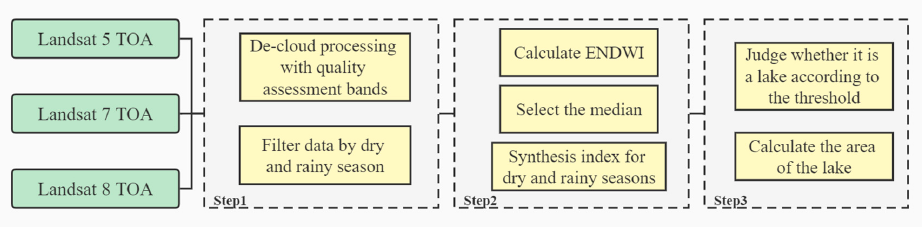
Figure 4. The workflow of the water body area calculation.